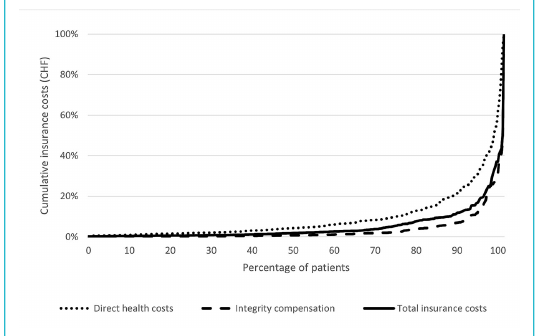
Figure 4: Percent distribution of cumulative insurance costs per percentage of patients.